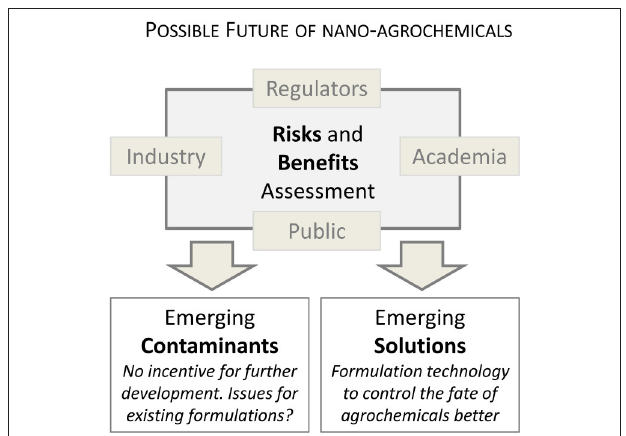
FIGURE 2 | The future of nanoagrochemicals may follow one of two scenarios. In the first (most likely in the current context), nanoagrochemicals are considered as emerging contaminants and the development of the technology will remain limited. The second scenario will require the establishment of highly collaborative and interdisciplinary research to provide fair assessment of both risk and benefits so that the full potential of (nano)formulations can be